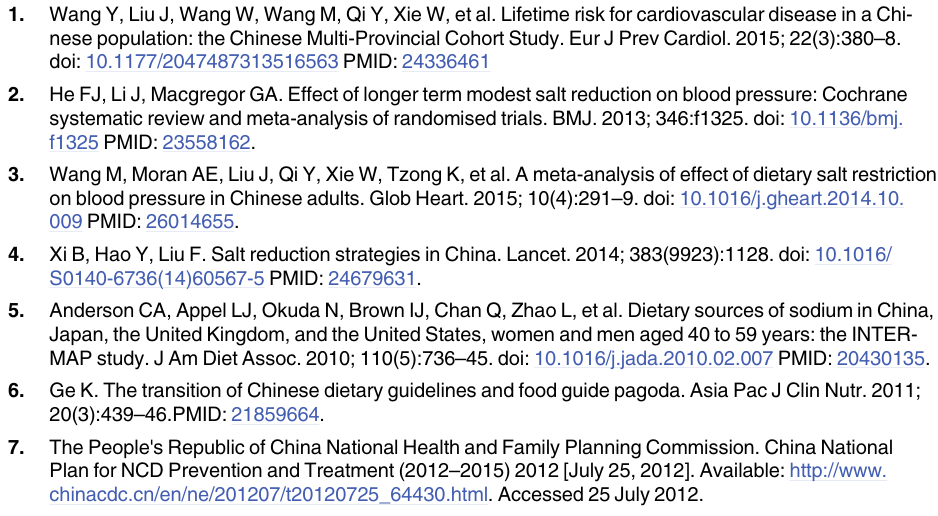
S1 Table. Results of one-way sensitivity analyses of the potential effects of salt restriction on CVD